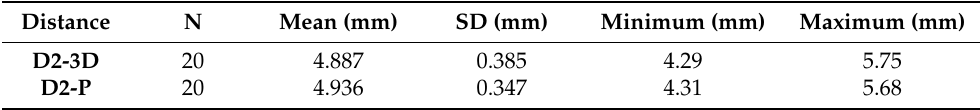
Table 4. Descriptive statistics regarding the distance from the ridge margin to the sinus window for rehearsals on 3D-printed models ( D2-3D ) and the distance from the ridge margin to the sinus window for implant procedures on patients ( D2-P ).